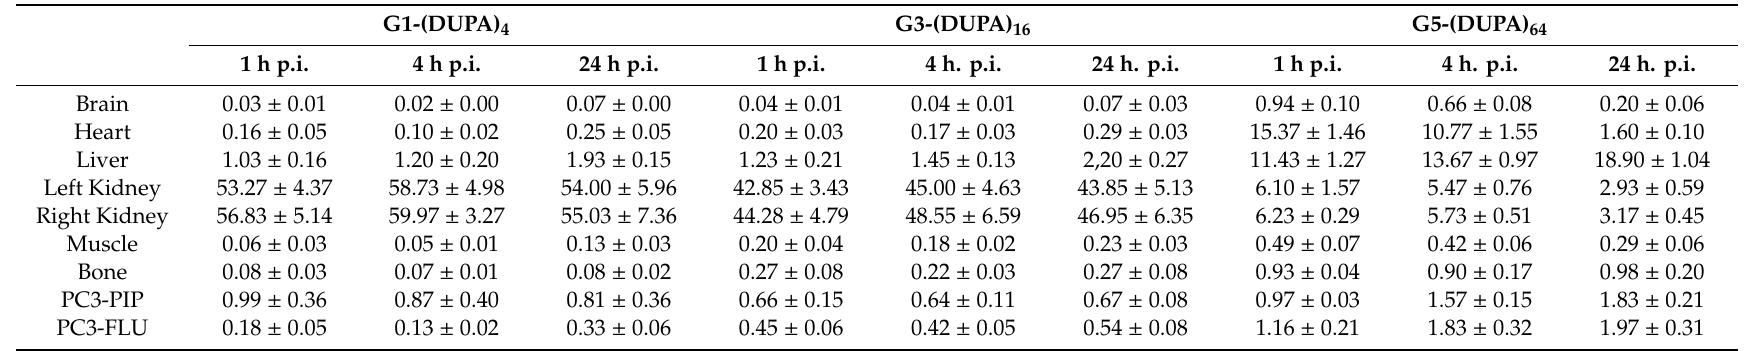
Table 1. In vivo organ uptake (%ID / g ± s.d.) of the 64 Cu-labeled dendrimers in SCID mice bearing PC3-PIP cells on the left shoulder and PC3-FLU cells on the right shoulder at 1, 4, and 24 h p.i. ( n = 3 for G1-(DUPA) 4 and G5-(DUPA) 64 ; n = 4 for G3-(DUPA) 16